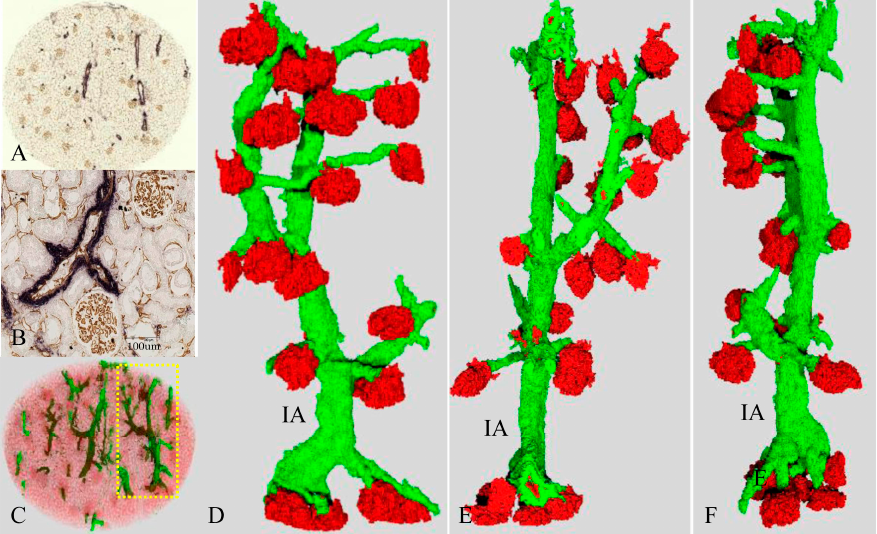
Figure 1. Vascular tree with glomeruli and the corresponding two-dimensional (2D) views in the patient with minimal Vascular Damage (Case 1). ( A , B ) original slice of a circular 3 × 3 mm core specimen with double immunostaining using anti-CD34 ( brown ) and then anti-SMA ( blue ); ( A ) and its magnified image ( B ); ( C ) three-dimensional (3D) reconstruction of the vascular tree; ( D – F ) an extracted vascular tree of yellow dotted circle of ( C ). IA is an interlobular artery; ( E , F ) rotated images of ( D ); and ( D – F ) original brown and blue correspond to red and green in the red-green-blue 3D images. Glomeruli can be identified as red figures. Arteries and arterioles are extracted as tubular formations of green SMA-positive smooth muscle cells. Interlobular arteries bifurcate and give rise to afferent arterioles, some of which branch off directly from large interlobular arteries ( D – F ).